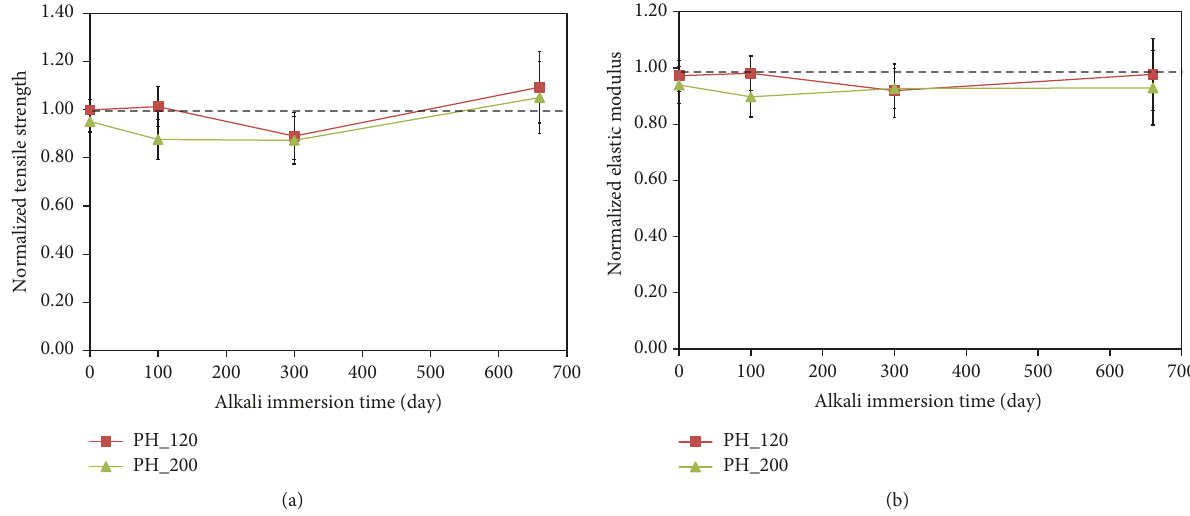
Figure 11: Comparison of tensile properties: (a) tensile strength and (b) elastic modulus (normalized with Ref specimens).